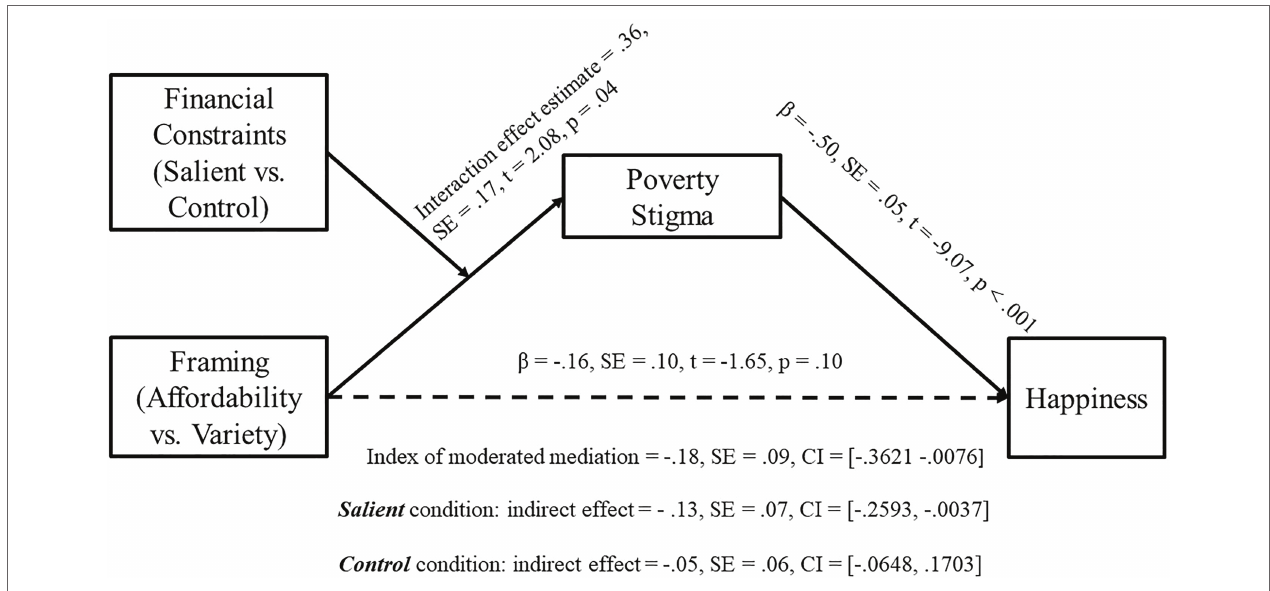
FIGURE 5 | Moderated mediation path diagram (Study